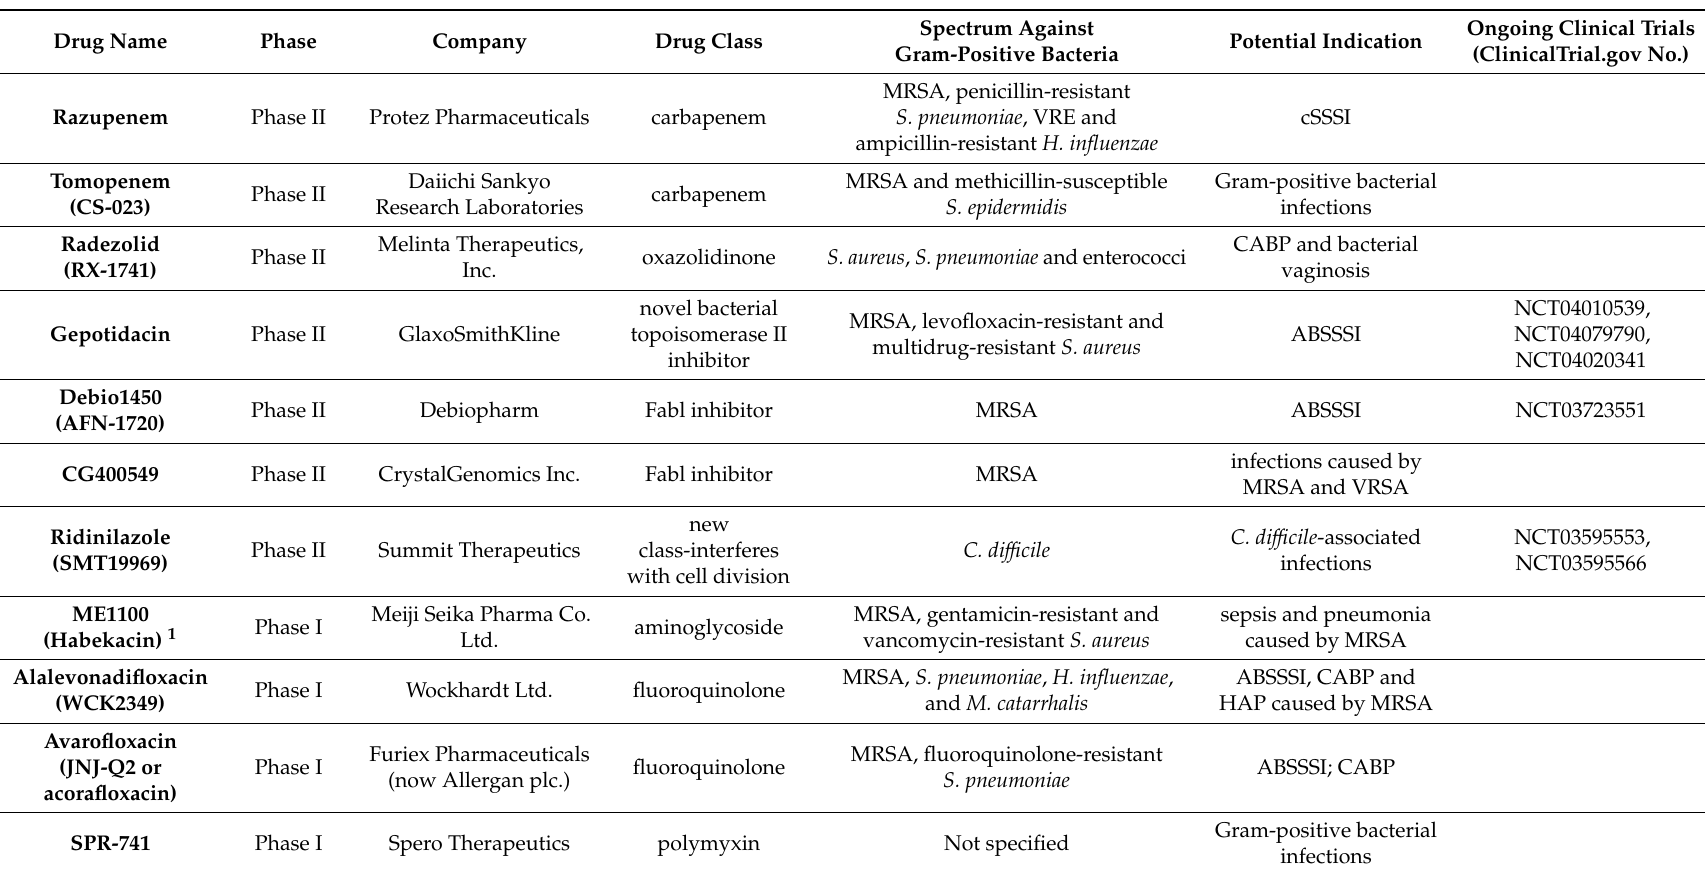
Table 2. Summary of antibiotics with activity against Gram-positive bacteria currently in Phase II and Phase I clinical